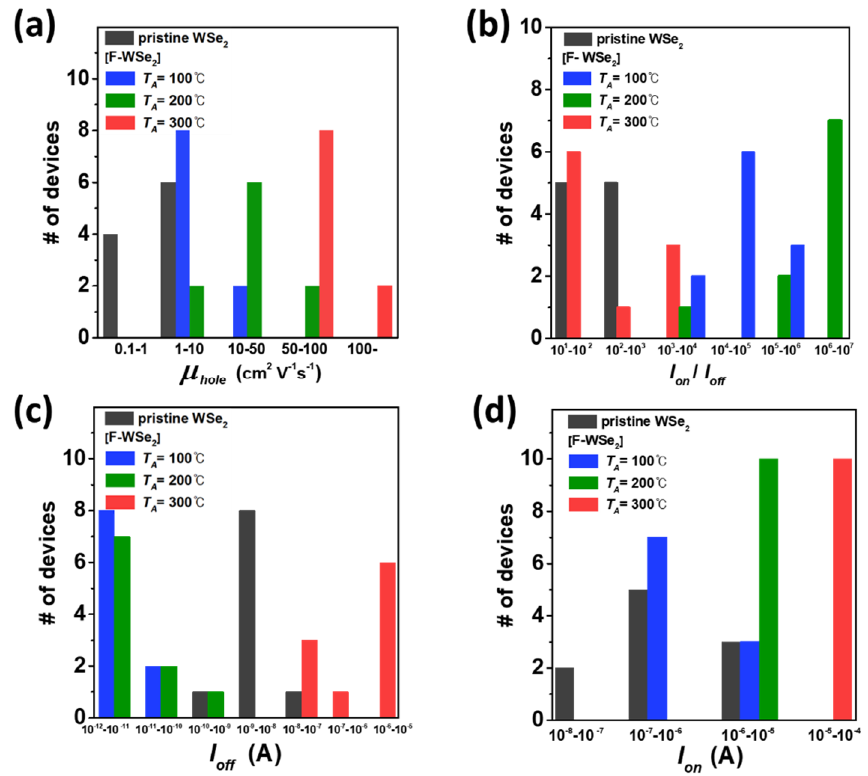
Figure 3. Histogram exhibiting statistical distributions of ( a ) carrier mobility, ( b ) on/off current ratio, ( c ) off current, ( d ), on